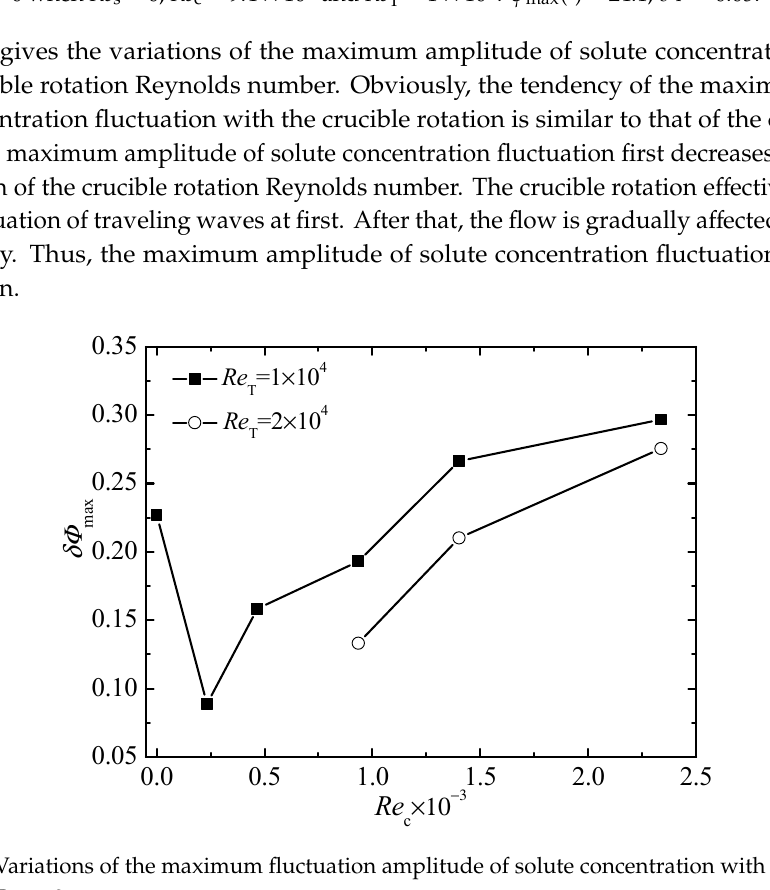
Figure 9. The streamlines ( left ) and iso-concentration lines ( right ) of 3D oscillation flow at the R - Z plane of θ = 0 when Re s = 0, Re c = 9.4 × 10 2 and Re T = 1 × 10 4 . ψ max (-) = 24.1; δΦ = 0.05.